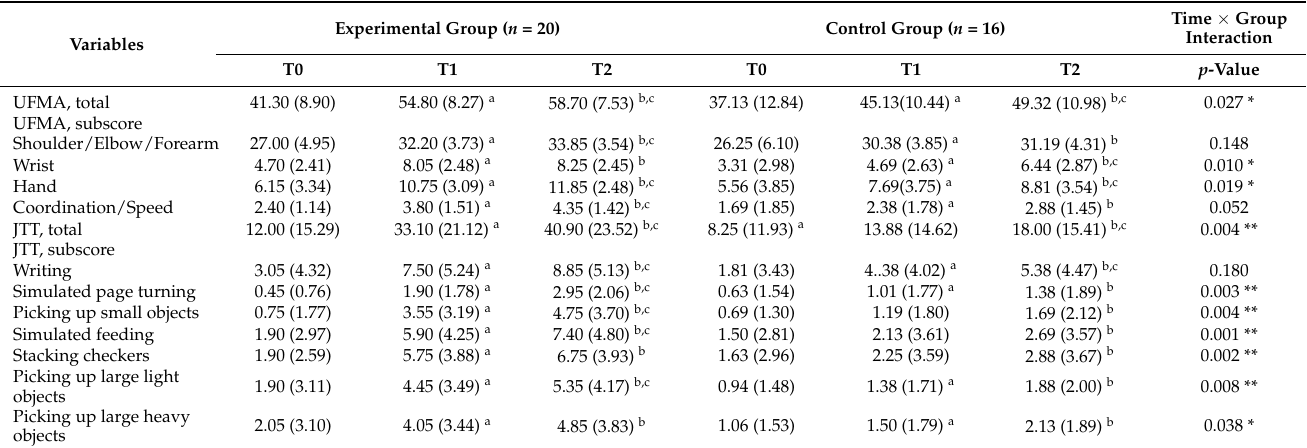
Table 2. Assessment scores for the affected upper extremity in the experimental and control groups.